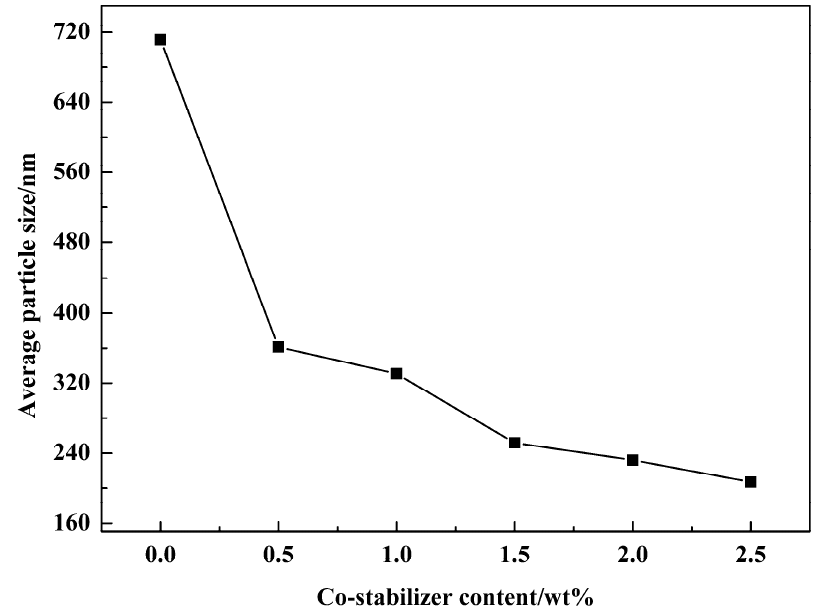
Figure 12. Average particle size of miniemulsions obtained by using a different amount of co-stabilizer.